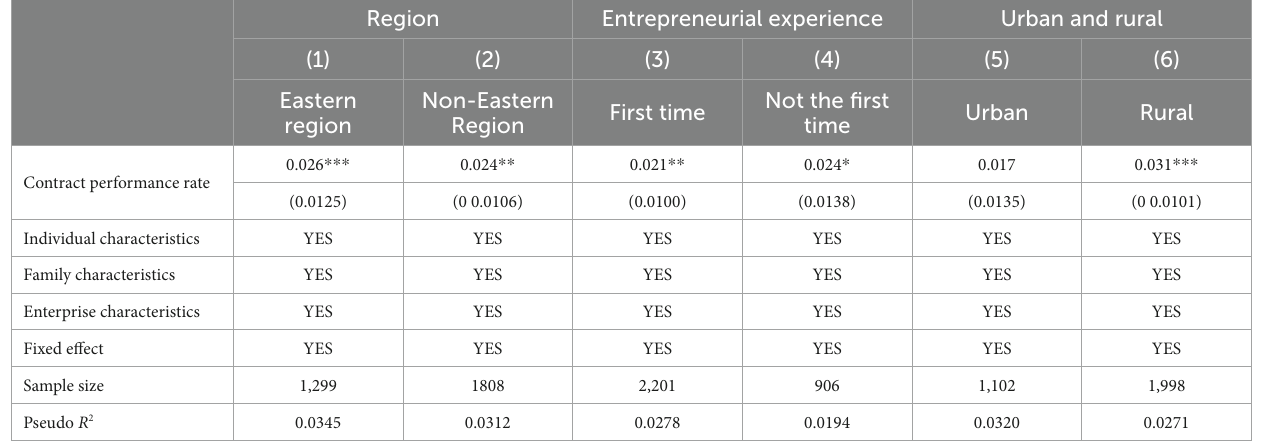
TABLE 8 Heterogeneity analysis results.